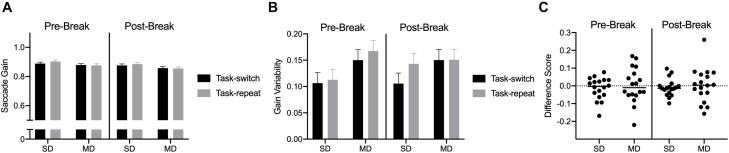
Experiment 2: Panels (A,B) show group mean gain and gain variability for pre- and post-break SD and MD task-switch and task-repeat saccades with errors bars representing 95% within-participant confidence intervals. Panel (C) presents participant-specific gain difference scores (task-switch minus task-repeat).